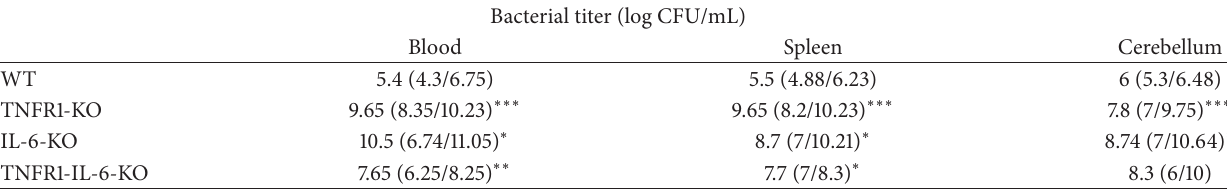
Table 1: Bacterial titers after pneumococcal